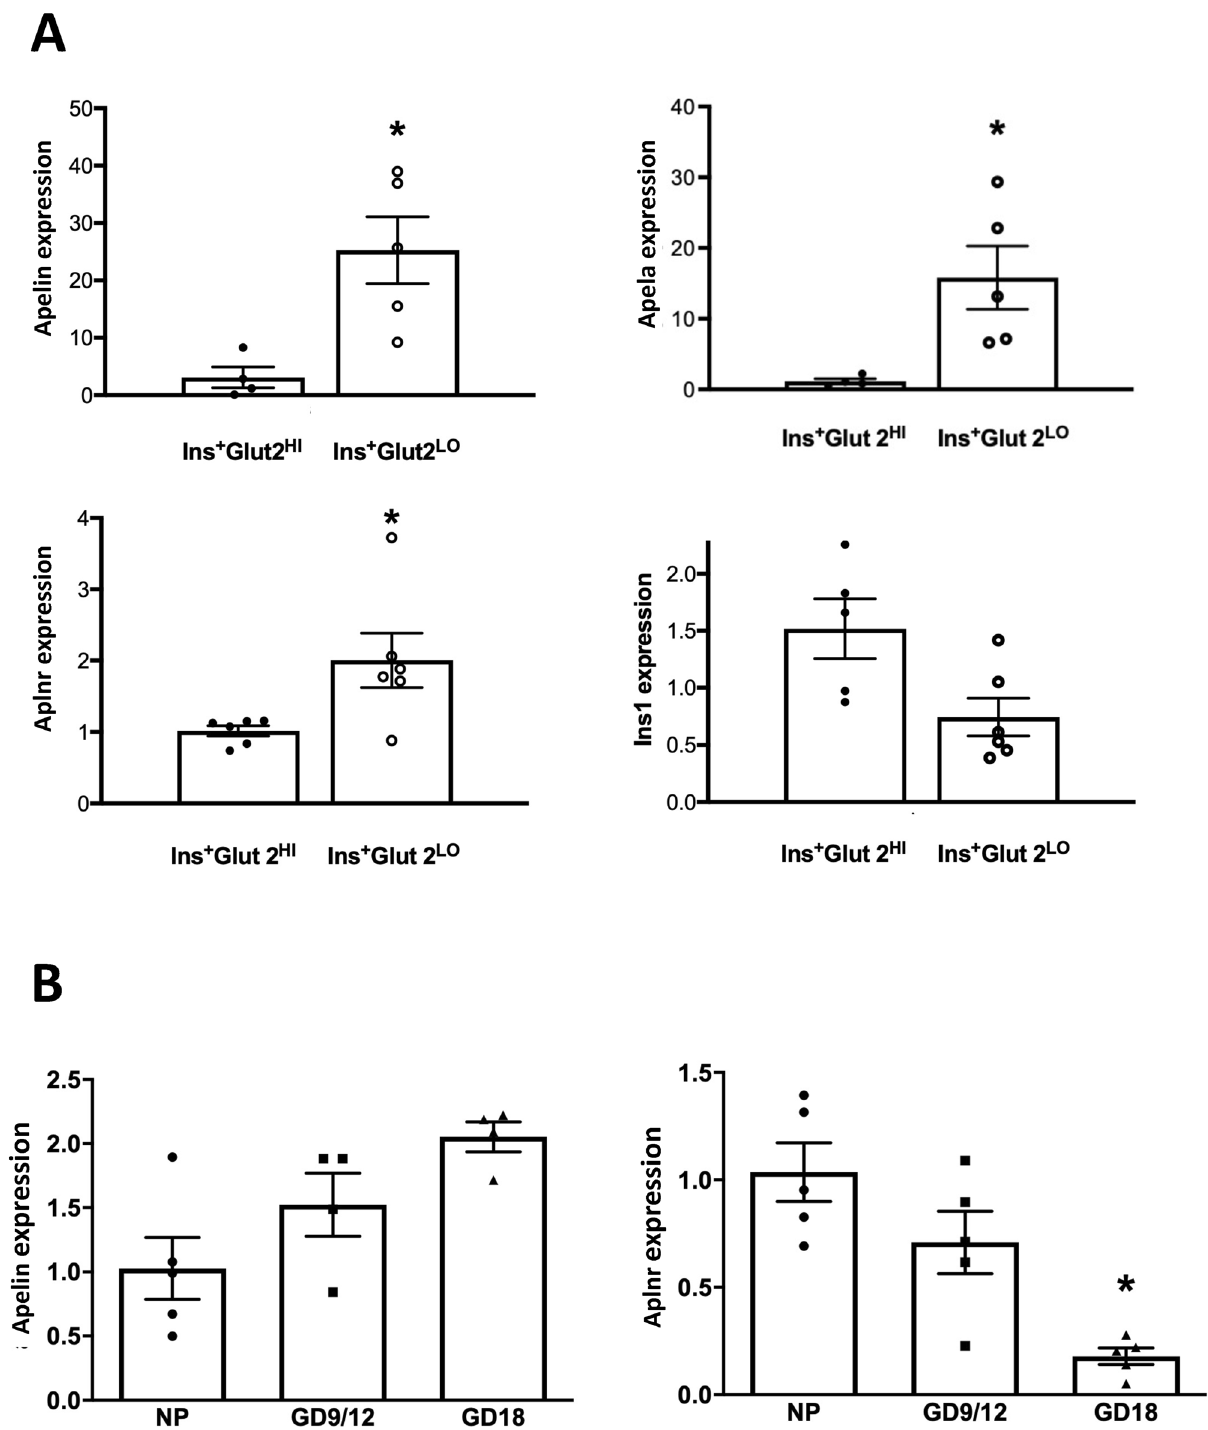
Figure 1. ( A ) Relative expression levels of mRNA for Apelin, Apela, Aplnr and insulin (INS1) quantified by qPCR in Ins + Glut2 HI (closed circles) and Ins + Glut2 LO (open circles) populations of β-cells isolated from neonatal mouse pancreas; and ( B ) Apelin and Aplnr expression in non-pregnant (NP) and pregnant mouse pancreas [gestational day (GD) 9–12 and 18]. Results are shown as fold increase compared to the geometric mean of the expression of housekeeping genes. Values represent mean ± SEM (n = 4–6). *p < 0.05 vs. Glut2 Hi in A, *p < 0.001 vs. NP in ( B